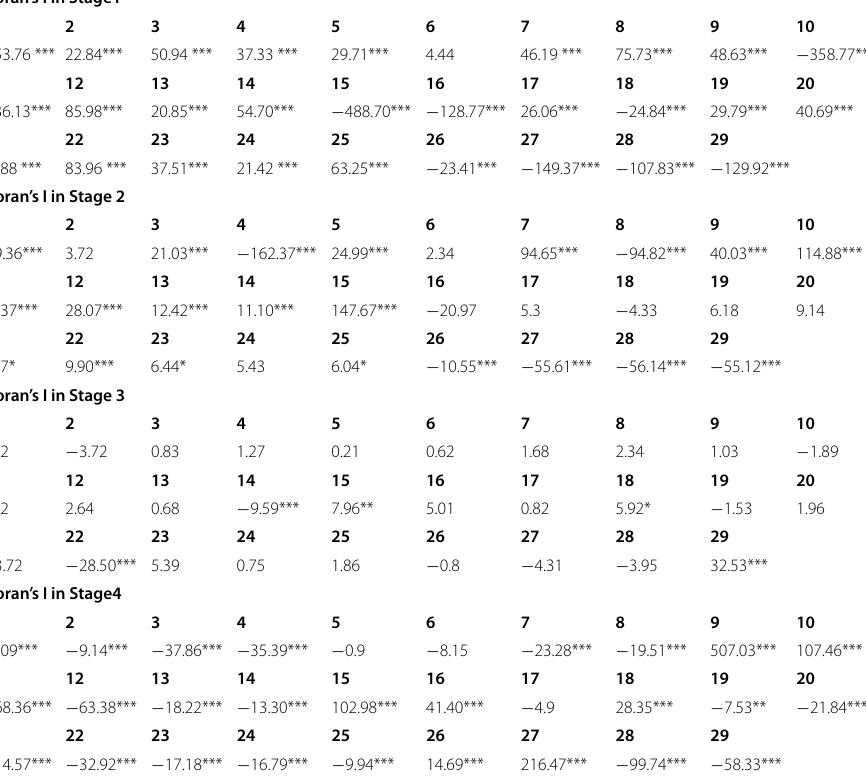
Table 4 Test results of spatial correlation for the 29 indices Moran’s I in